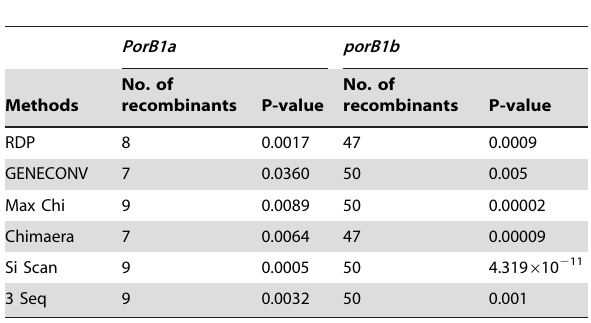
Table 4. No recombination was found in three PIA isolates: SK- 39420, A-87, and V-004. The majority (94%; n =63) of PIB isolates were recombinants, whereas four isolates, SK-4981, SK- 25465, SK-23596, and SK-32711, all from Canada, had no detected recombination. The most numerous recombination event (Table 4), beginning at 27 bp and ending at 493 bp positions of the aligned DNA sequences, was identified in isolates from North Table 4. Two major recombination events at PIA and PIB nucleotide